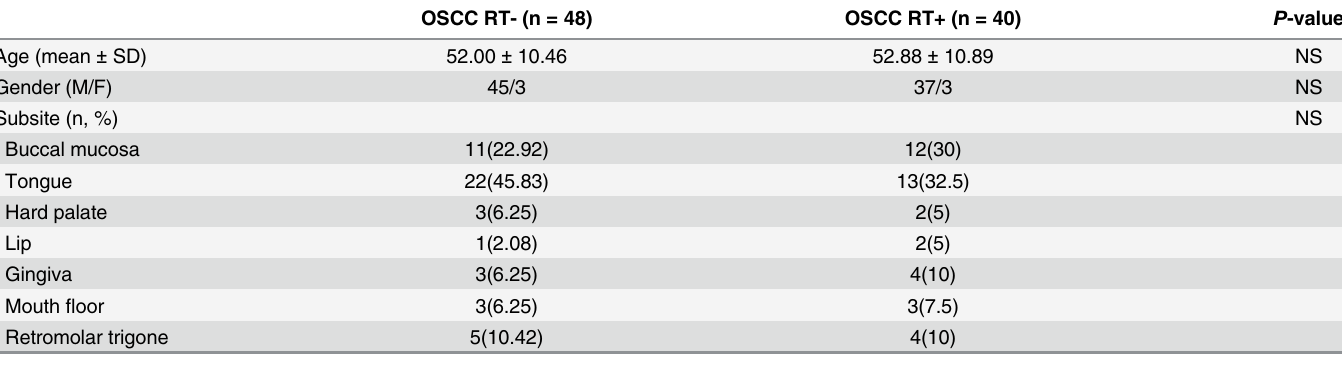
Table 1. A comparison of demographic features in treated OSCC patients between the group without prior neck radiation (RT-) and that with previ- ous neck RT